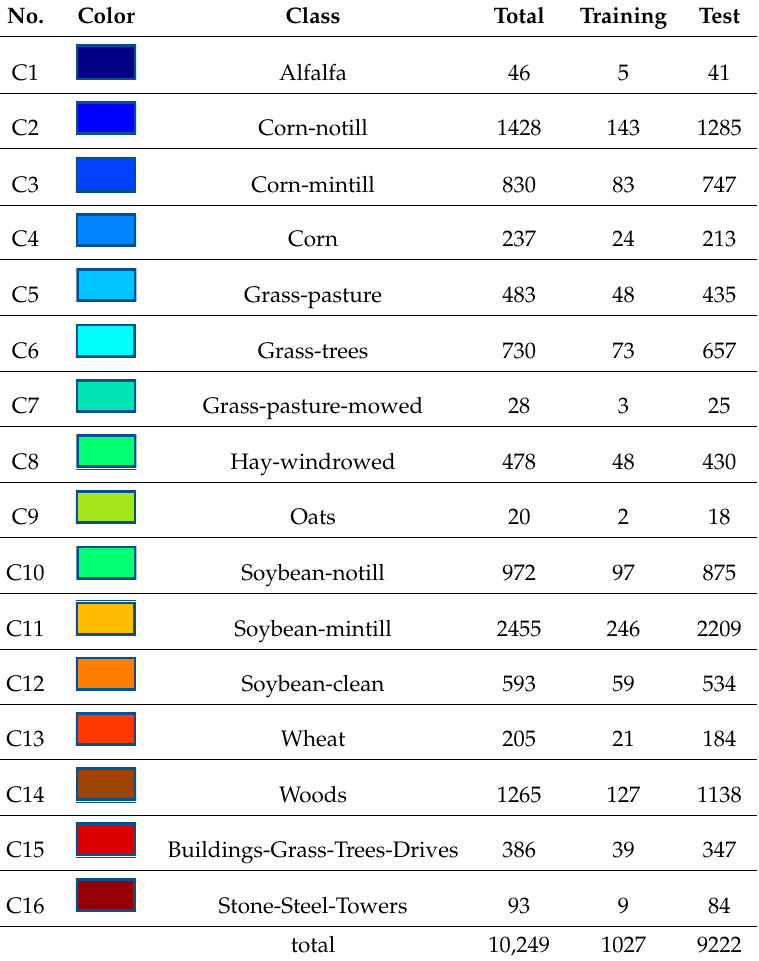
Table 1. Indian pines data for various training samples and test samples.